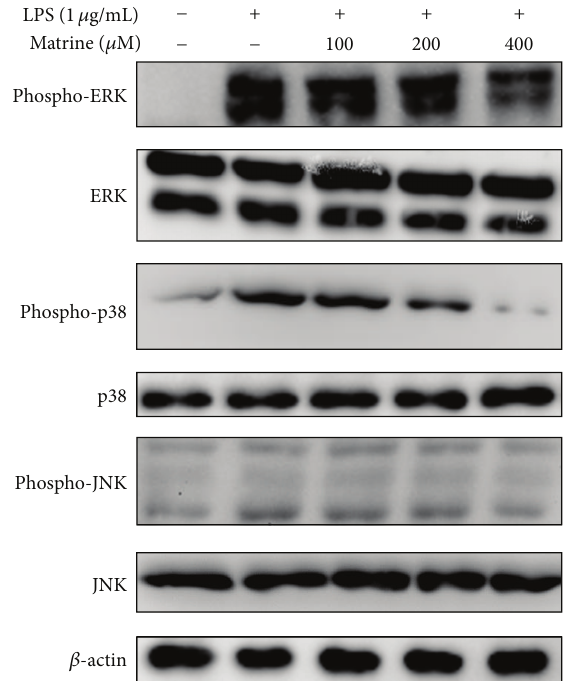
Figure 4: Matrine affects LPS-induced phosphorylation of MAPK pathway molecules. Western blots showed the effects of the indicated matrine concentrations on the phosphorylation of ERK ( top two rows ), p38 ( middle two rows ), and JNK ( bottom two rows ). Three independent experiments were analyzed and compared with the LPS-treated group.